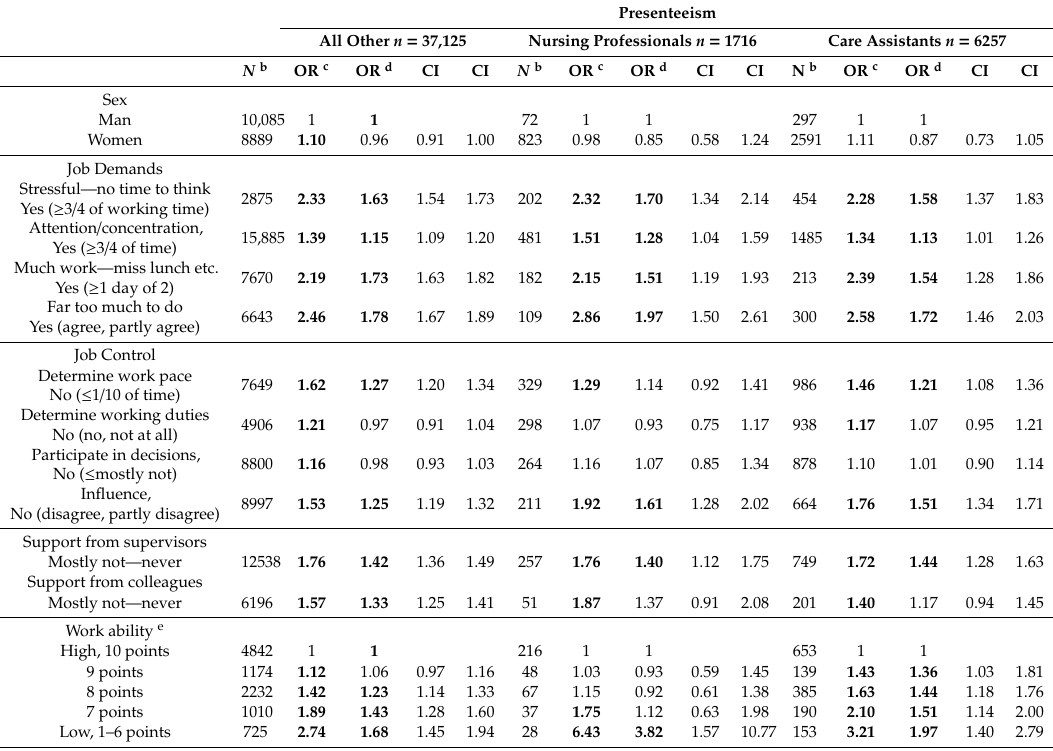
Table 4. Associations between presenteeism and sex, psychosocial variables, and work ability, stratified by occupation a . Number of cases and odds ratios (ORs) with 95% confidence intervals (CIs) are